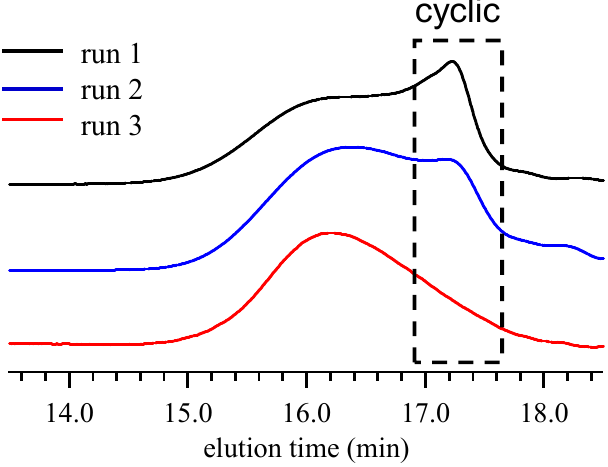
Figure 1. SEC traces of 3,6-PCzs obtained from runs 1, 2, and 3 in Table 1).